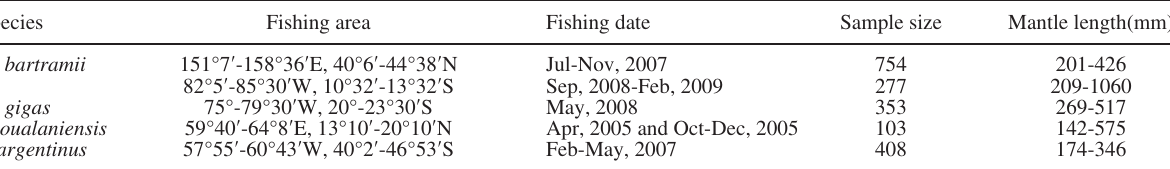
T able 1. – The fishing area, fishing date, sample number and mantle length of the different species included in this study.